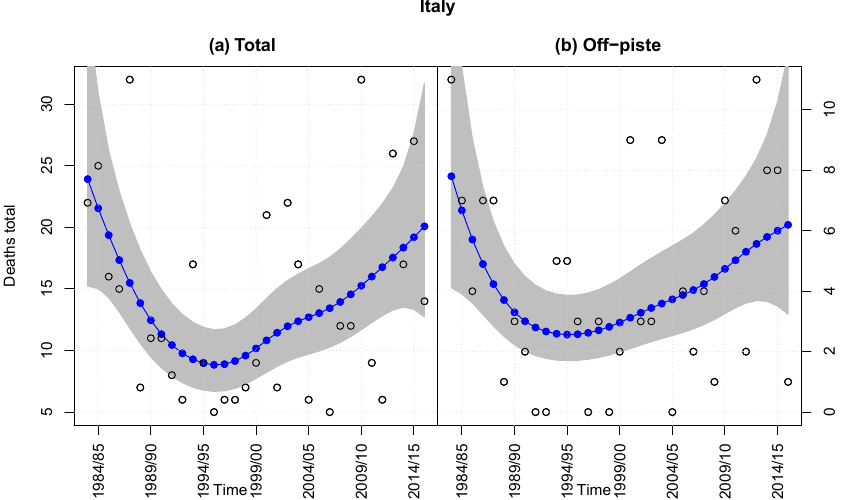
) annual avalanche fatalities – off-piste and backcountry, i.e., total (a) , and off-piste (b) – with 90% Figure 5. Observed ( ◦ ) and estimated ( • confidence bands (grey) in Italy within 1983/1984–2015/2016.